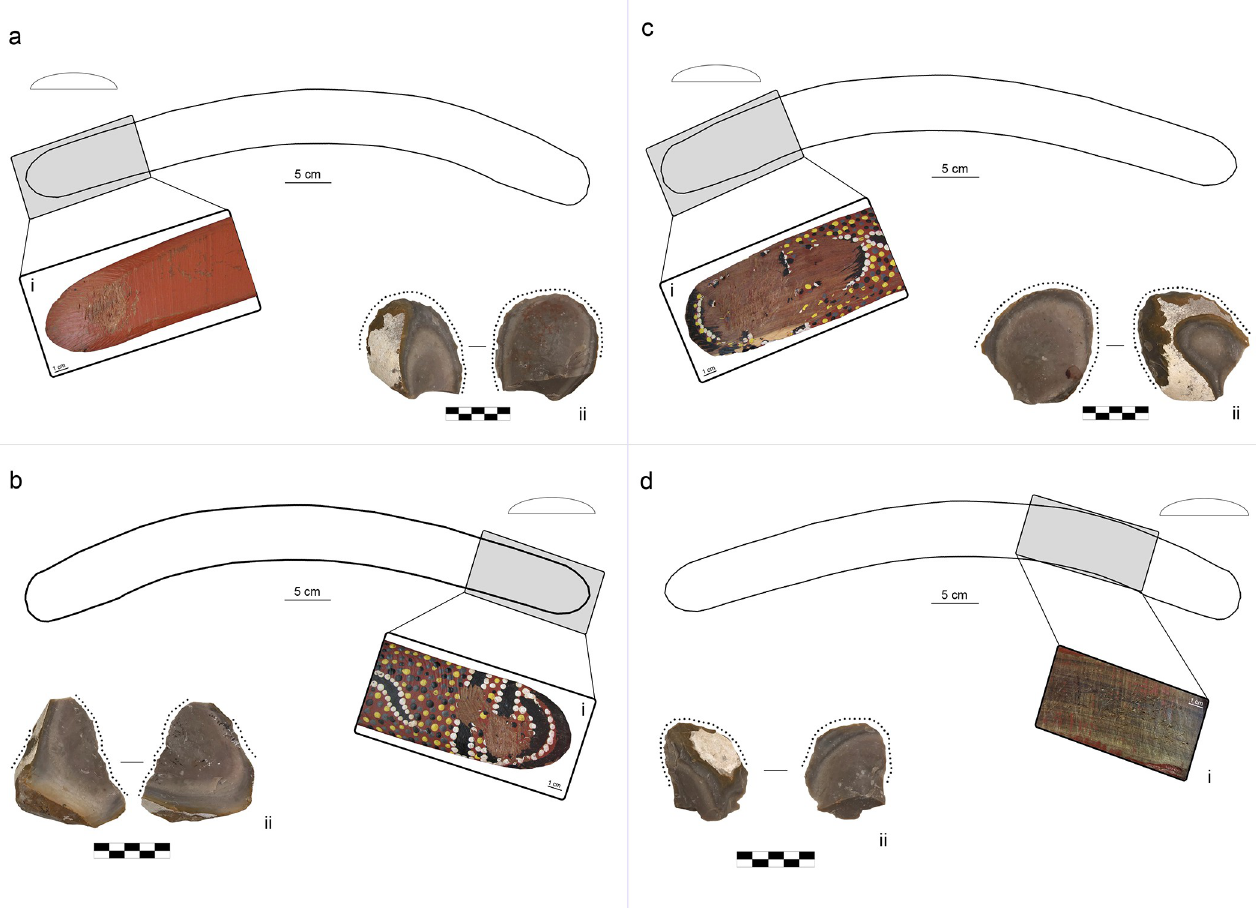
Fig 2. Results of retouching session 2 on the boomerang B1 (plano-convex cross-section and location of use areas). (a) location of use area B1_1, (i) use area B1_1 (1x), (ii) retouched flake F56; (b) location of use area B1_2, (i) use area B1_2 (1x), (ii) retouched flake F59. (c) location of use area B1_3, (i) use area B1_3 (1x), (ii) retouched flake F51; (d) location of use area B1_4, (i) use area B1_4 (1x), (ii) retouched flake F90.